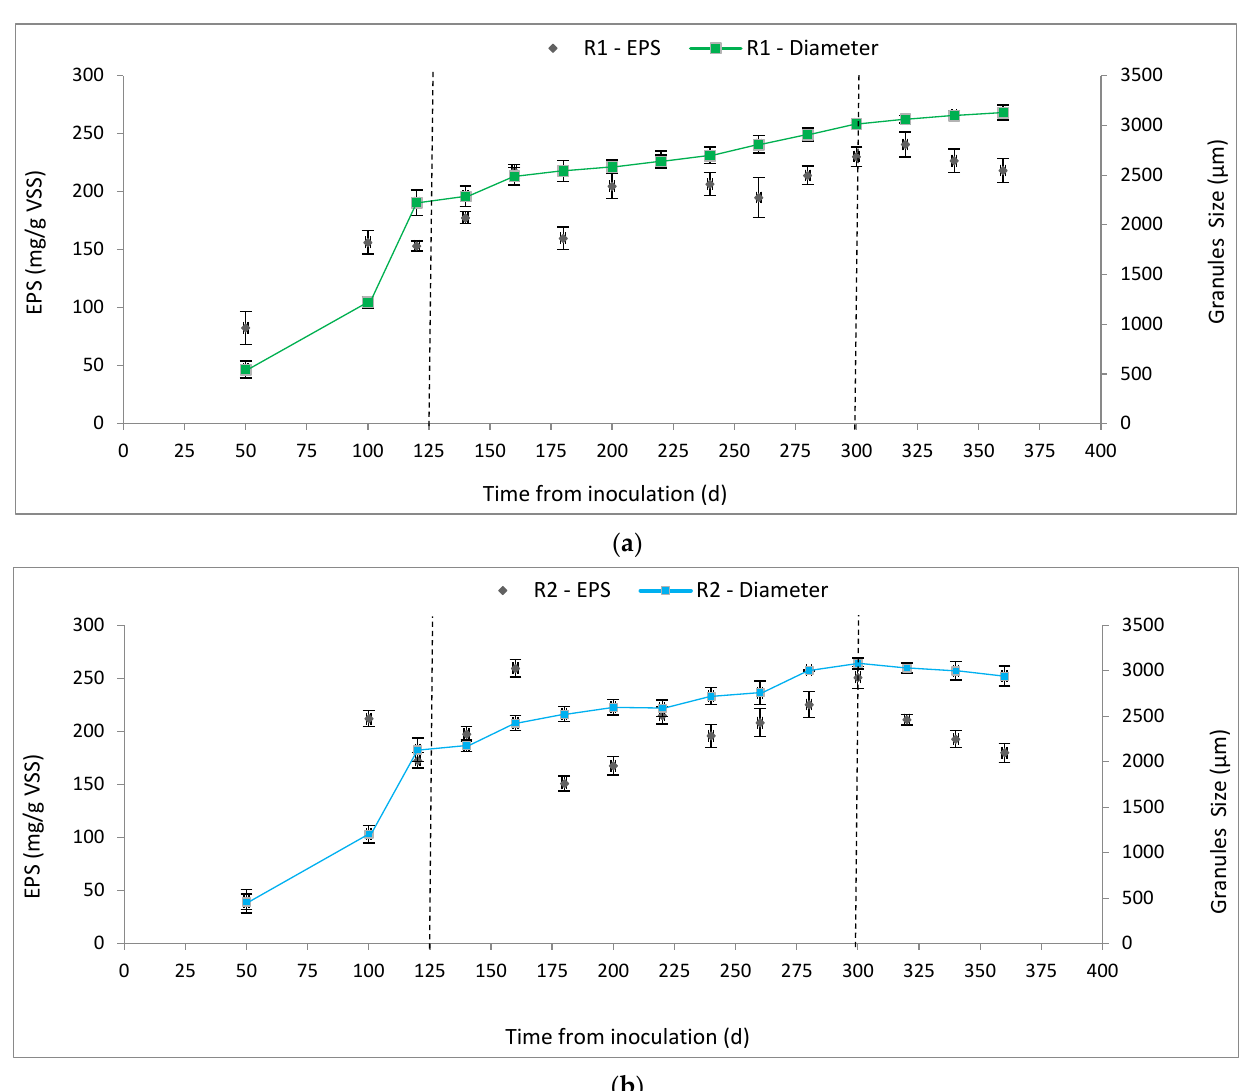
Figure 3. EPS measurements (protein + carbohydrate) over the entire operational period (360 days) of ( a ) R1 and ( b ) R2.